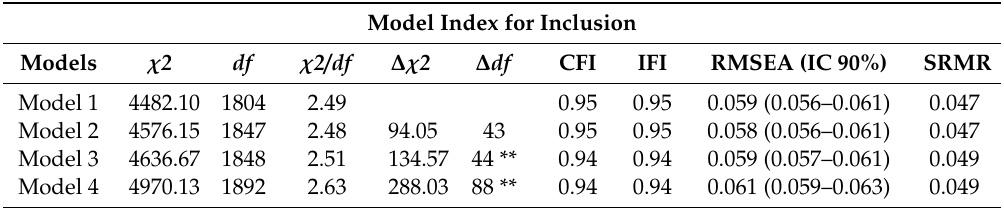
Table 2. Multi-group analysis of family invariance.